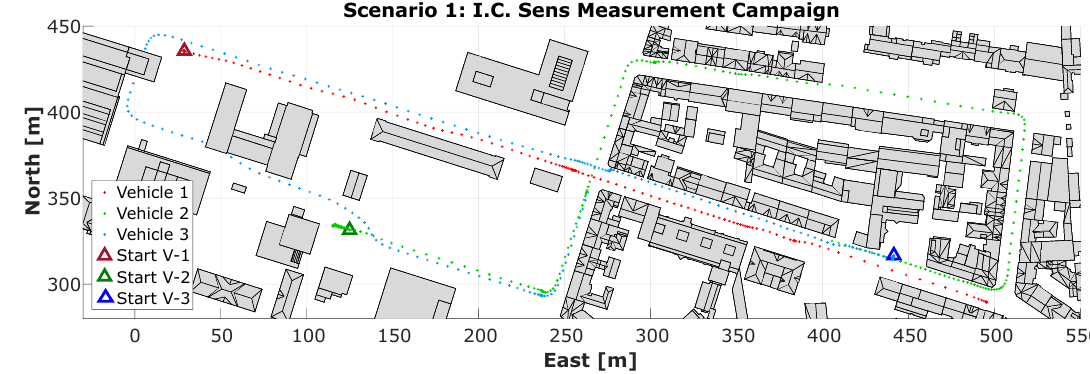
Figure 8. Schematic overview of the first Meet & Greet scenario, combining the measured GNSS data with a Level Of Detail 2 (LOD 2) city model as done in Section 3.3. i.c.sens, integrity and collaboration in dynamic sensor